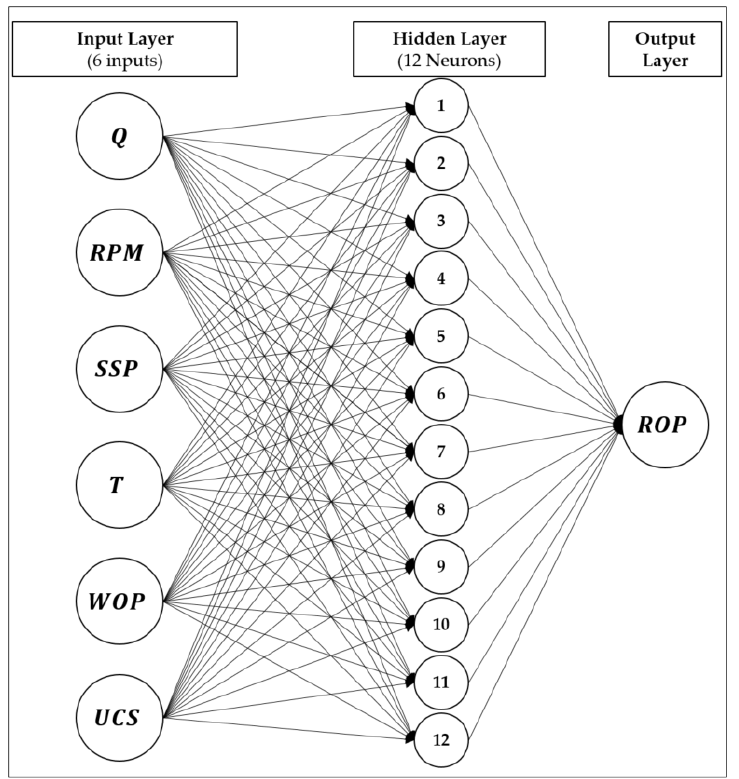
Figure 3. Artificial neural network (ANN) model structure for ROP prediction.